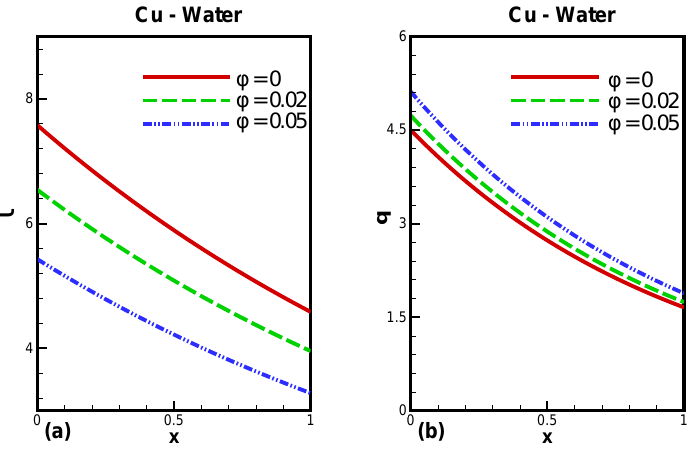
Figure 5. Effect of copper nanoparticle volume fraction φ on dimensionless ( a ) wall shear stress and ( b ) heat transfer rate at the wall, when β = 1, R e = 1, δ = 0.2, B r = 6, P e = 1, and γ = 0.2.